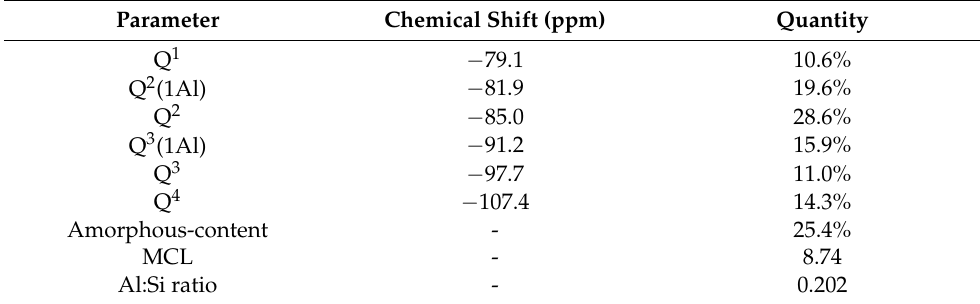
Table 3. Relative abundance of Q n species and their chemical shifts, amorphous-content, mean aluminosilicate chain length (MCL), and Al:Si ratio of tobermorite in TOB-7. Parameter